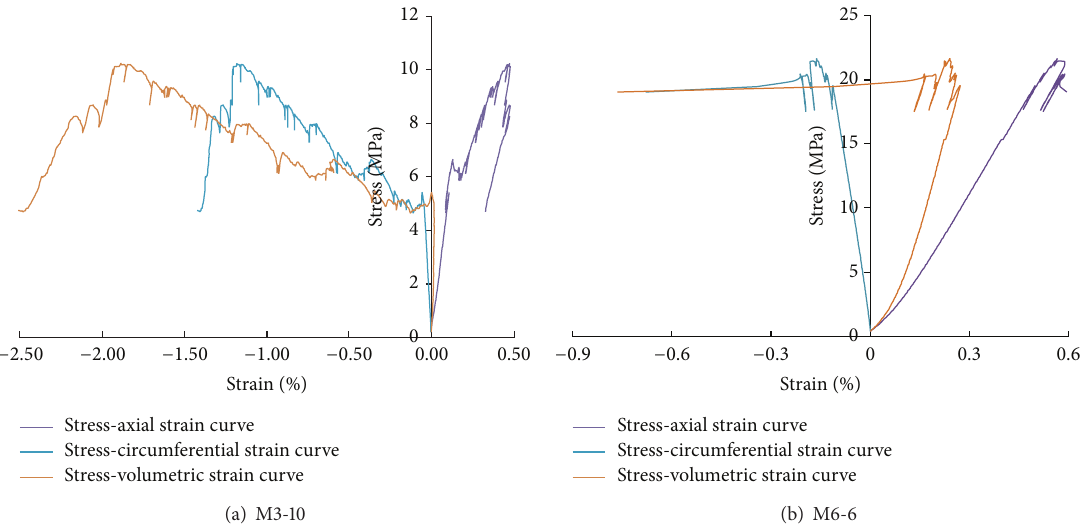
Figure 4: Complete stress-strain curves of typical specimens (M3-10 parallel specimen and M6-6 perpendicular